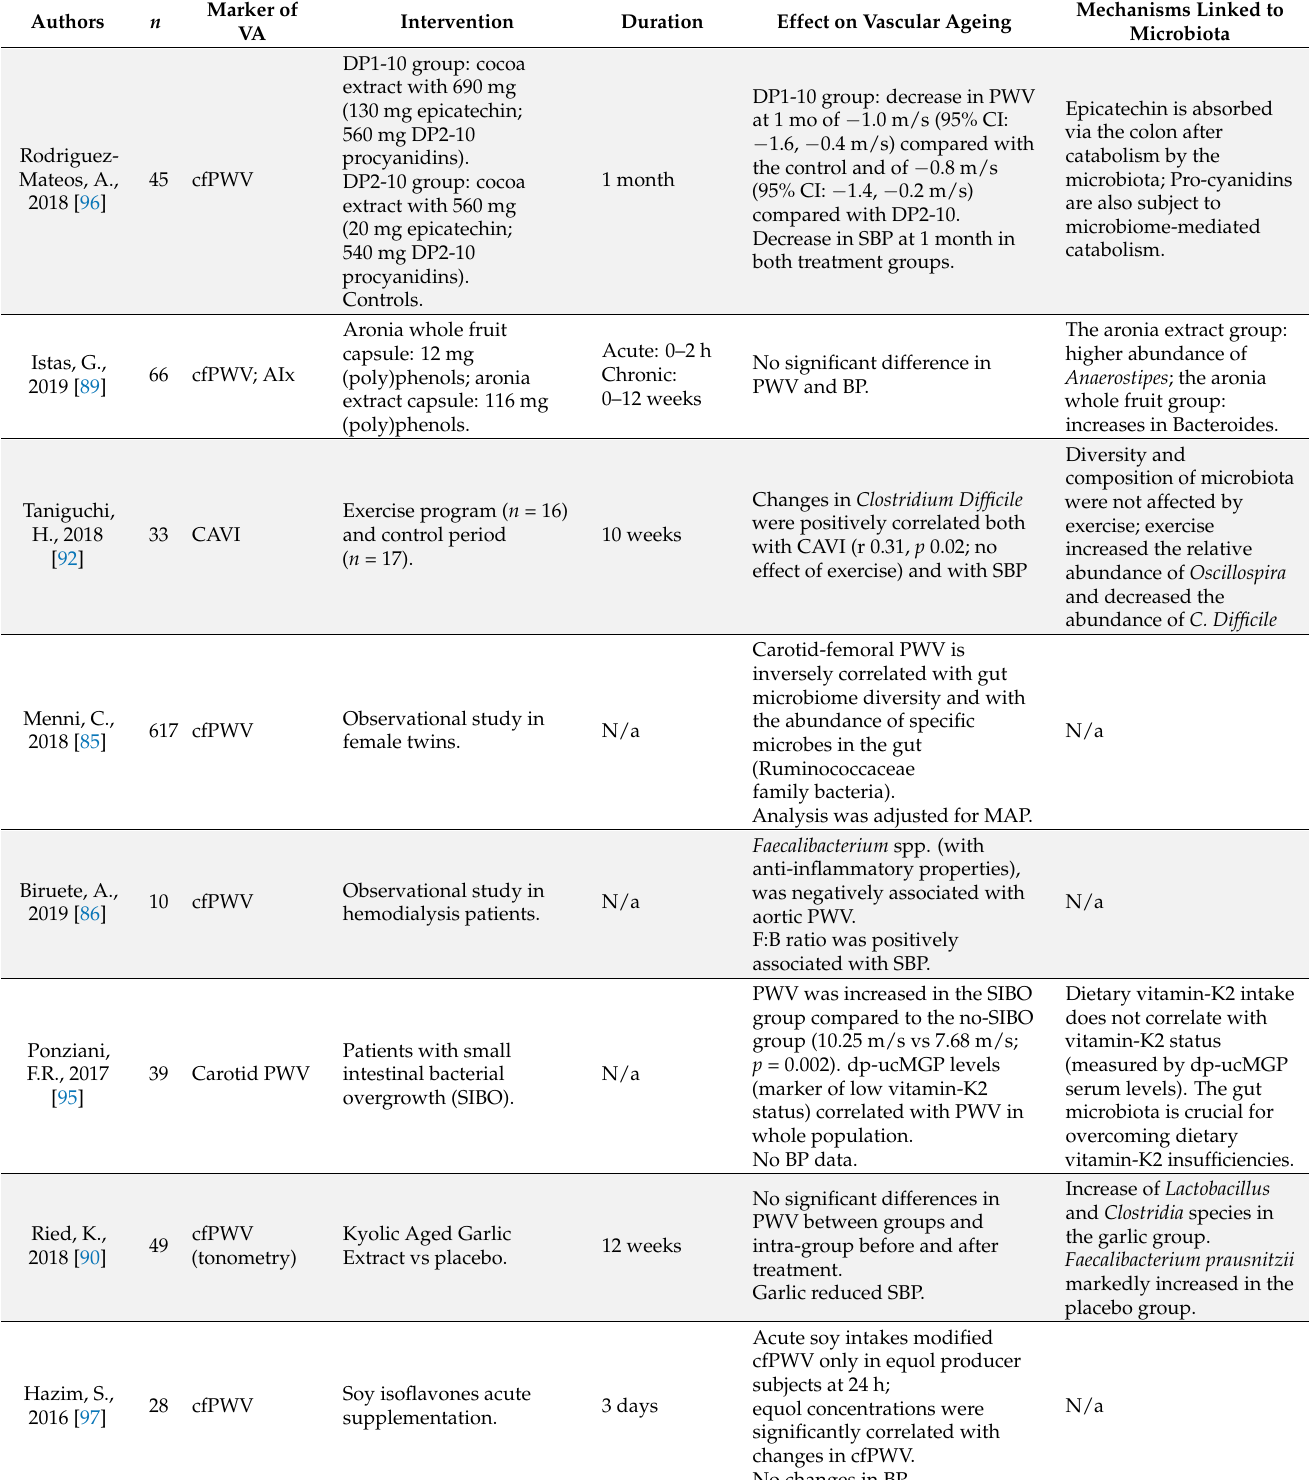
Table 2. Characteristics of human